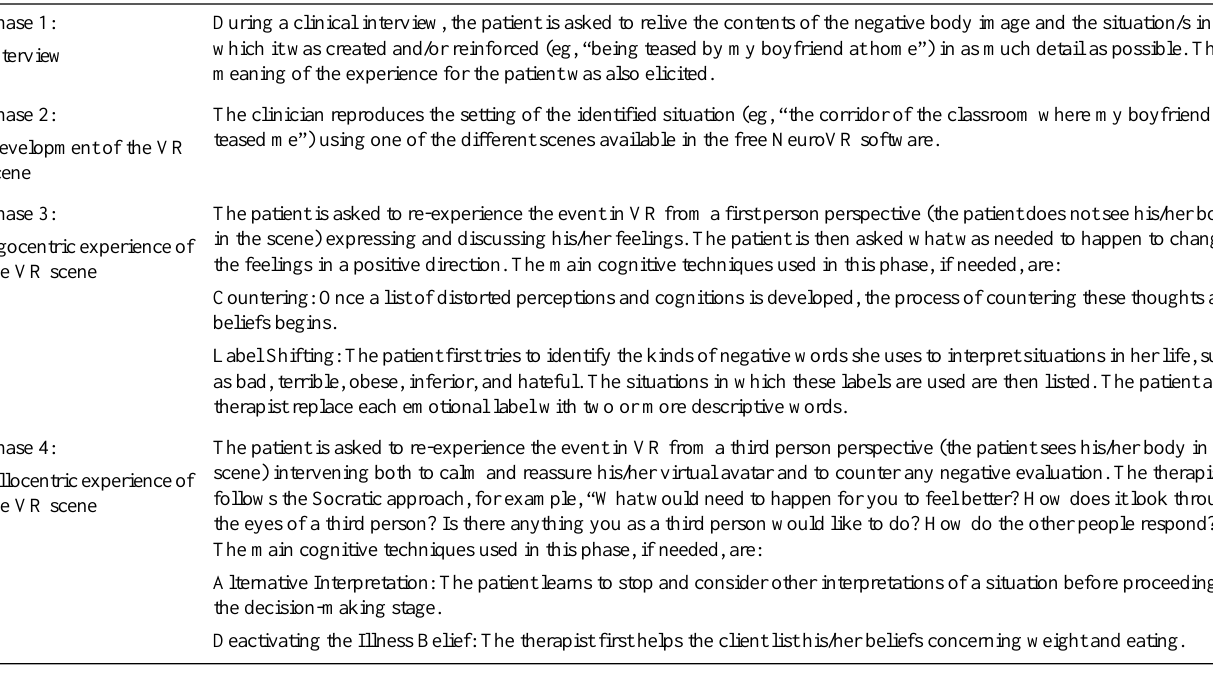
the decision-making